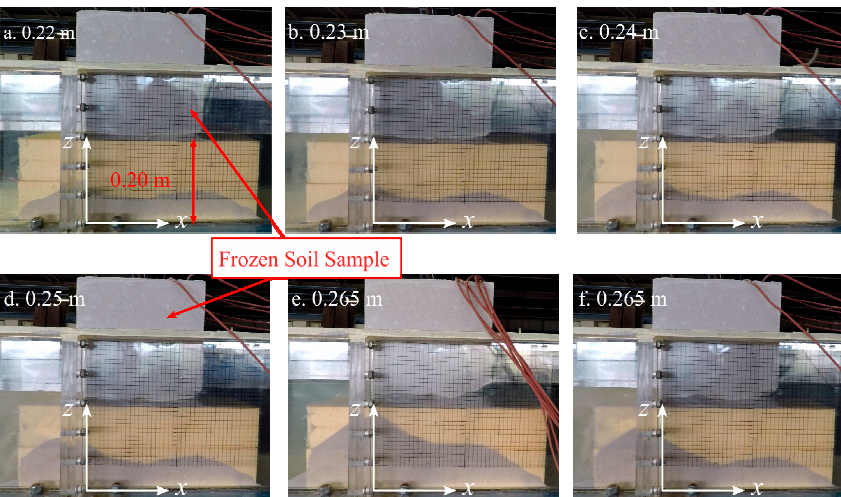
Figure 9. Frozen soil specimen of Exp. 2 in the flume on polystyrene plates exposed to the hydrostatic water level. The initial deep water depth was 0.20 m. The flume was then slowly filled with water. As the frozen specimen thawed immediately in contact with water, the filling was stopped at a water depth of 0.265 m. Small currents due to the filling process led to a wash out of the loose sediment causing high turbidity. Panels ( a )–( f ) show the filling of the flume stepwise to the water level that is indicated in each panel.